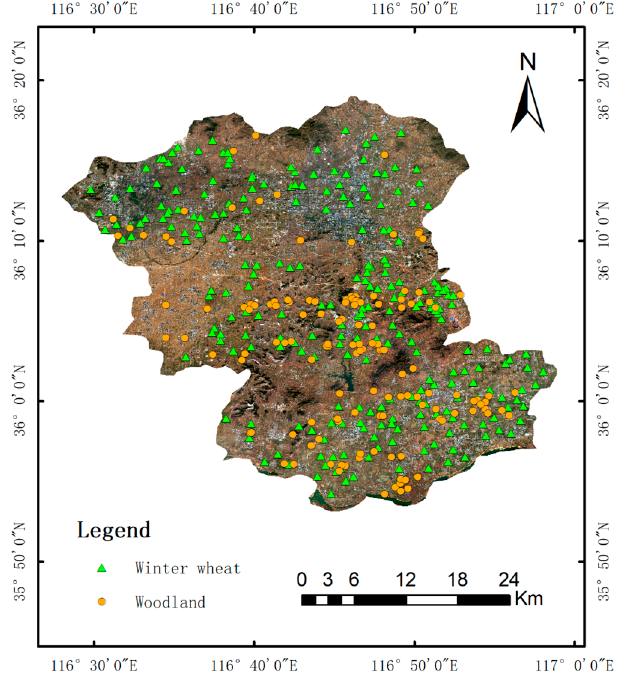
Figure 2. The distribution of sampling points acquired via ground investigation.